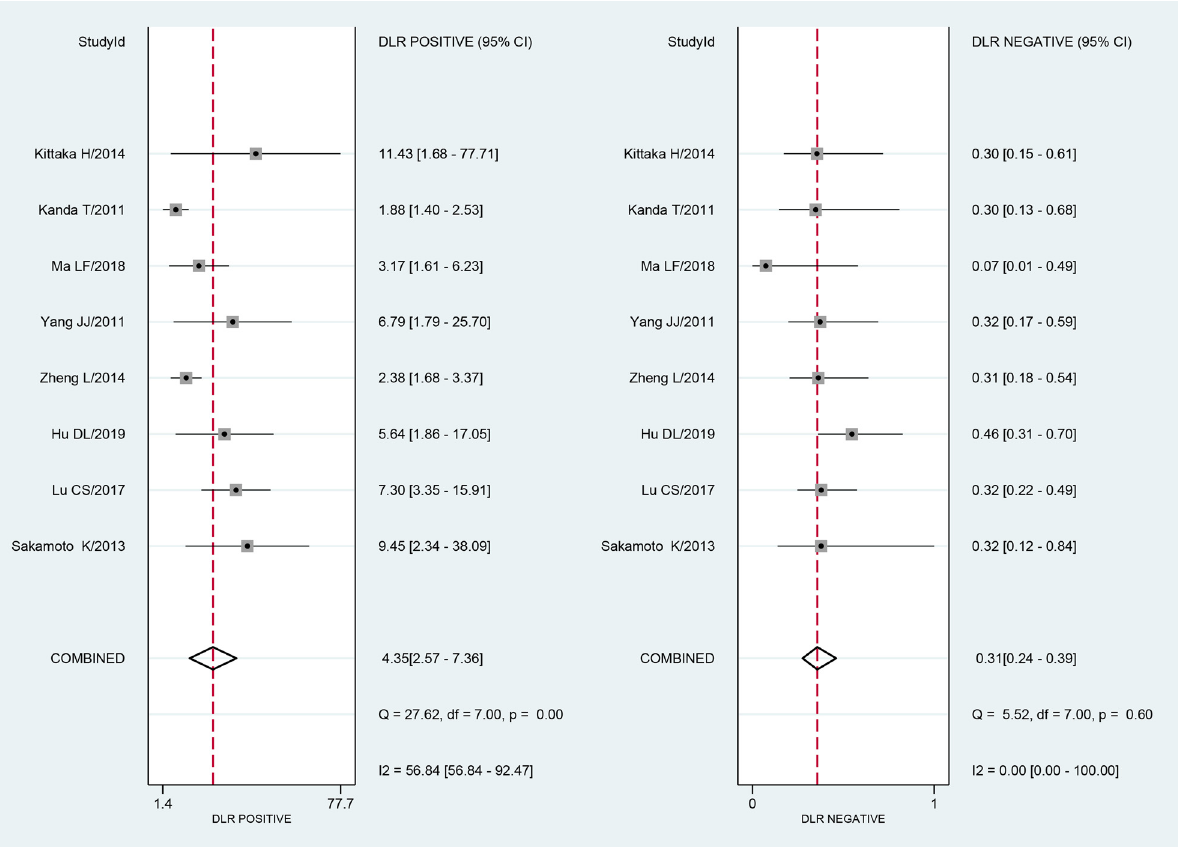
Figure 3: The forest plot of the diagnostic PLR and NLR for serum I - FABP in diagnosis of strangulated intestinal